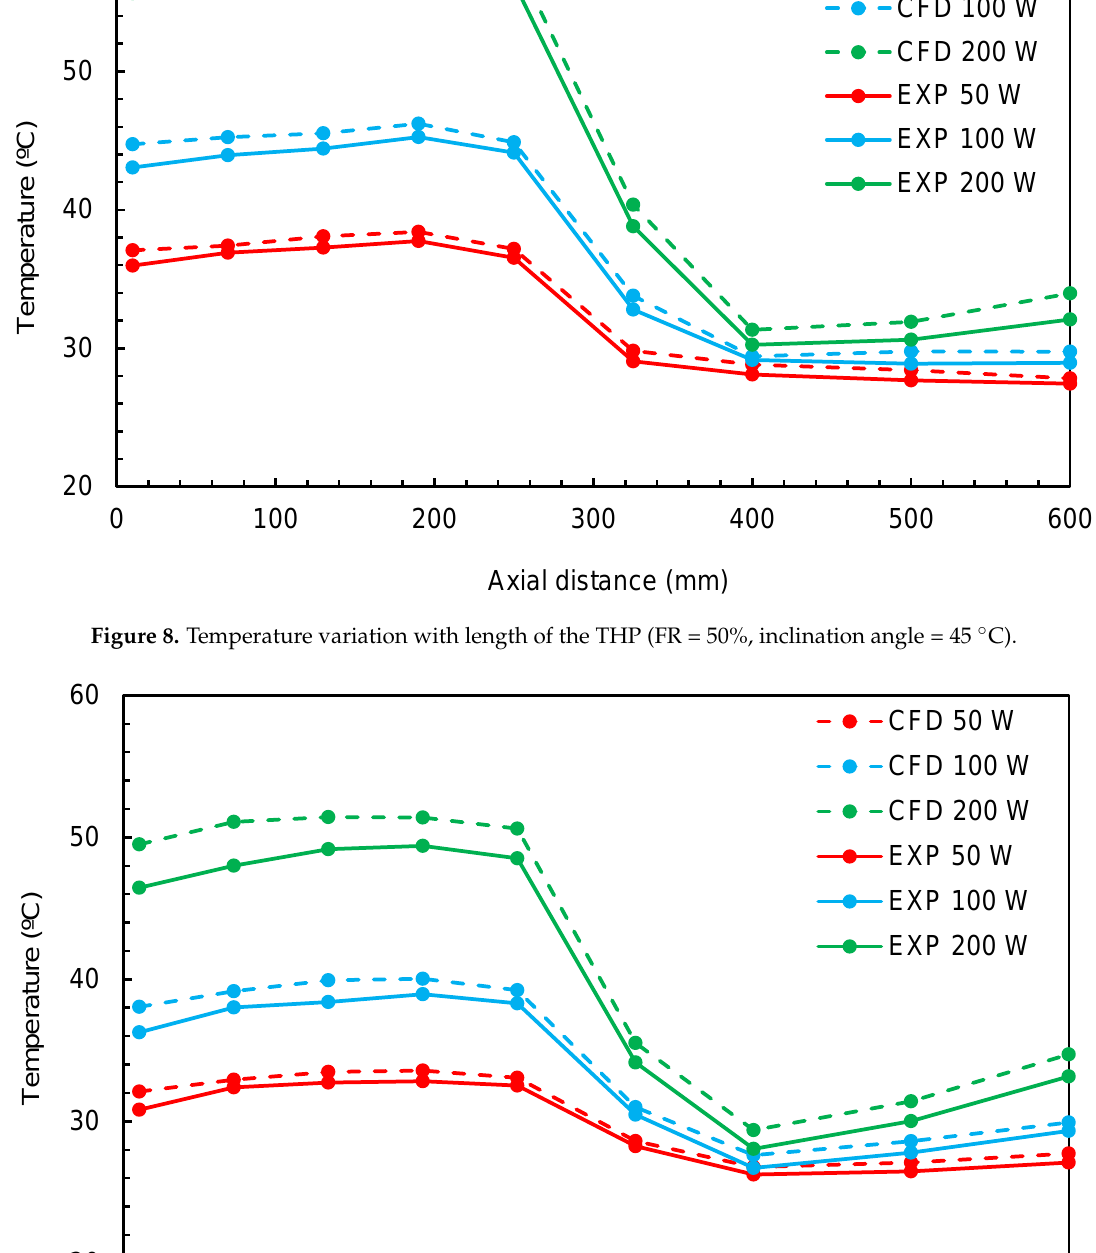
Figure 9. Temperature variation with length of the TPTHP (FR = 50%, inclination angle = 45 °C).